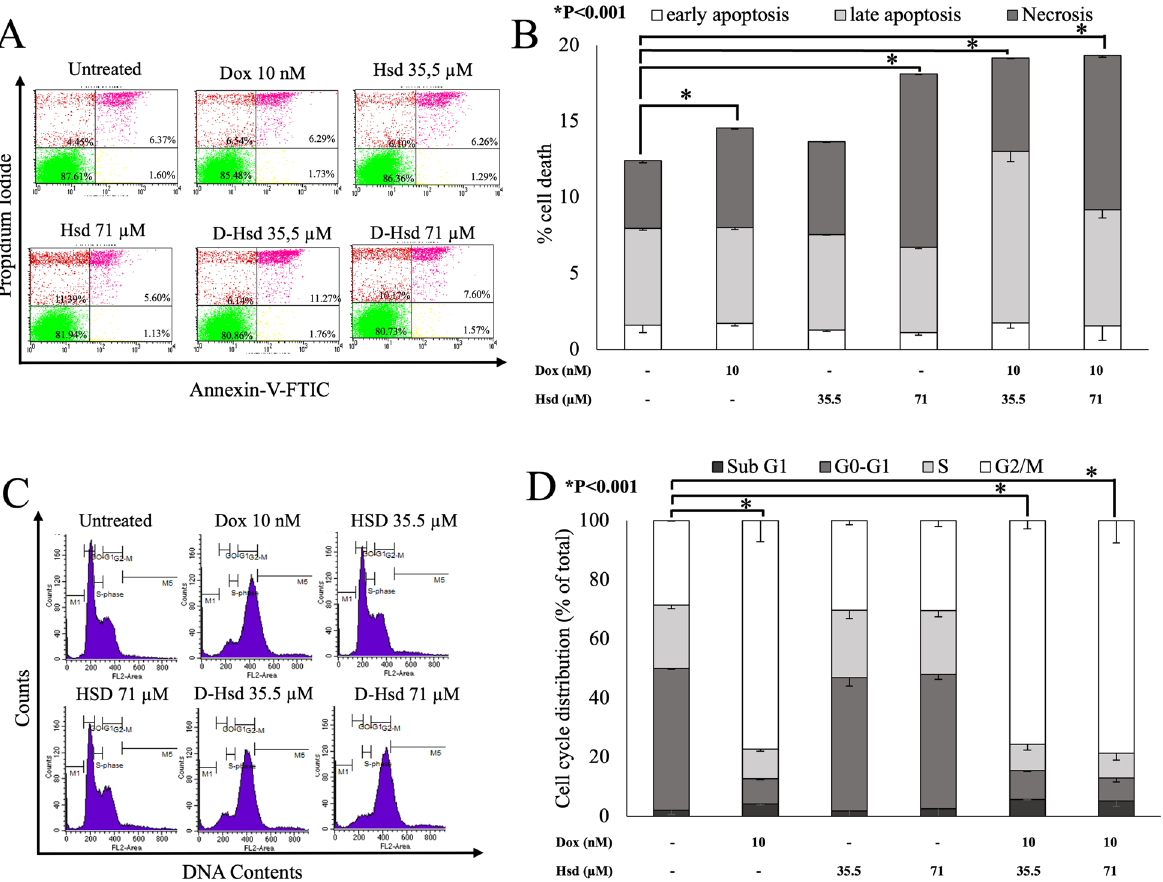
Fig. 2 Induction of apoptosis and cell cycle distribution by Hsd, DOX, and combination treatment on 4T1 breast cancer cells. Cells were exposed with Hsd and DOX individually or in combination for 24 h. % cell death ( A , B ) and % cell distribution in each phase ( C , D ) were measured by flow cytometry after staining with Annexin V-FITC/PI and PI, respectively. The bar represents the mean experiment. * p < 0.001 (post-hoc LSD test between each group) was considered statistically